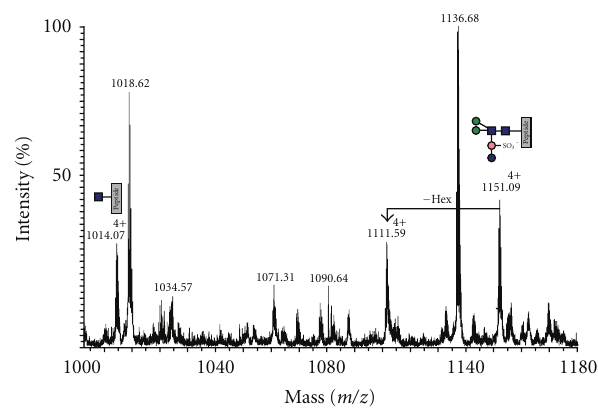
Figure 4: Summed mass spectra recorded between 46 and 52 min from an on-line nanoLC-ES-MS/MS analysis of an in-gel tryptic digest of the S-layer. The quadruply charged signals at m/z 1014.07, 1111.59 and 1151.09 are molecular ions of glycopeptides of sequence GAGVVEFLLTAYPYTGNITFAPPWFIAENVVK carrying the glycans shown in the annotations. Unassigned signals are molecular ions of peptides from elsewhere in the